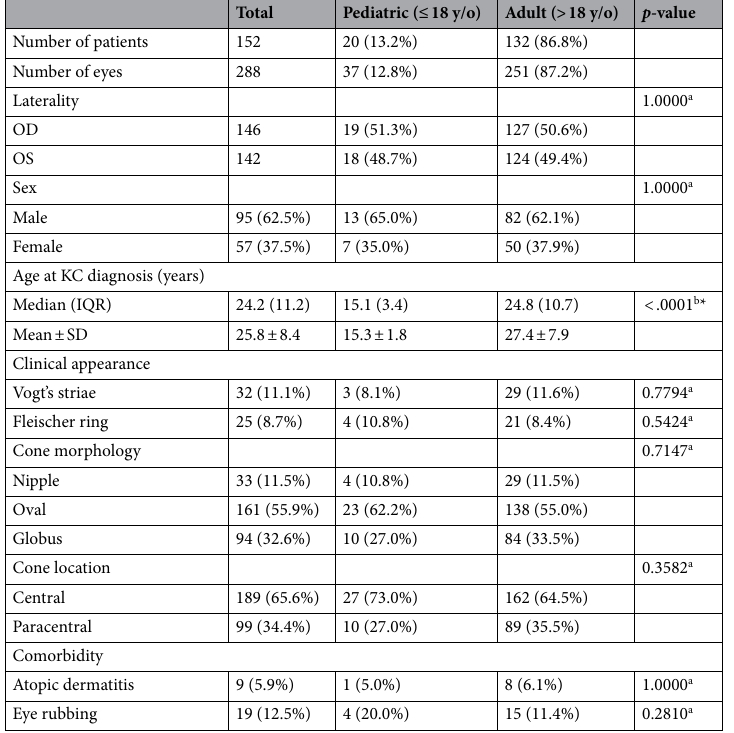
Table 1. Demographic and clinical characteristics of patients with keratoconus at the initial diagnosis. a Fisher exact test. b Wilcoxon rank-sum test. KC: keratoconus. OD: right eye. OS: left eye. y/o: years old. SD: standard deviation. *statistical significance according to the sequential Bonferroni-type procedure, because the smallest p was < i/46* 0.05 for the 41multiple tests in Tables 1 and